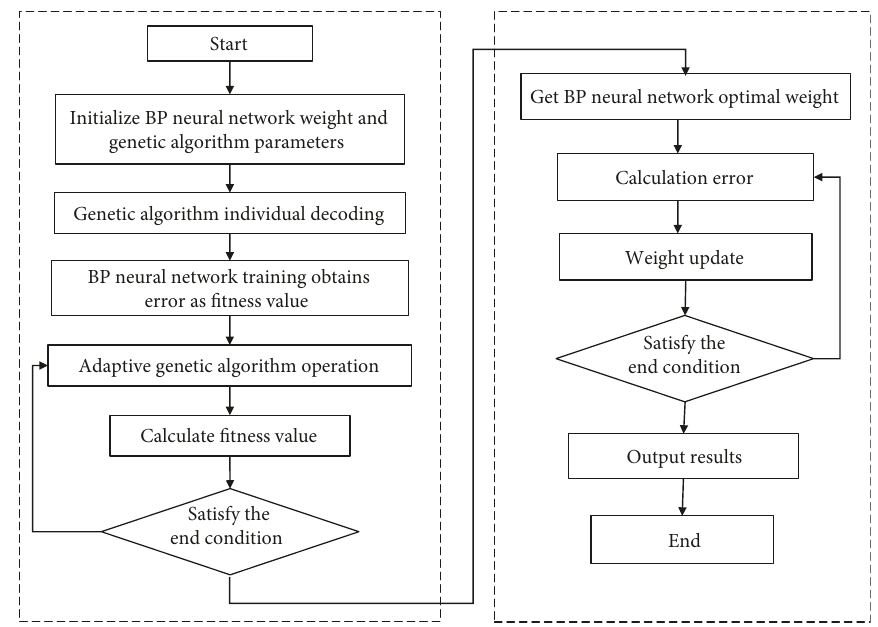
Figure 7: Flow diagram of BP neural network algorithm based on optimization of adaptive genetic